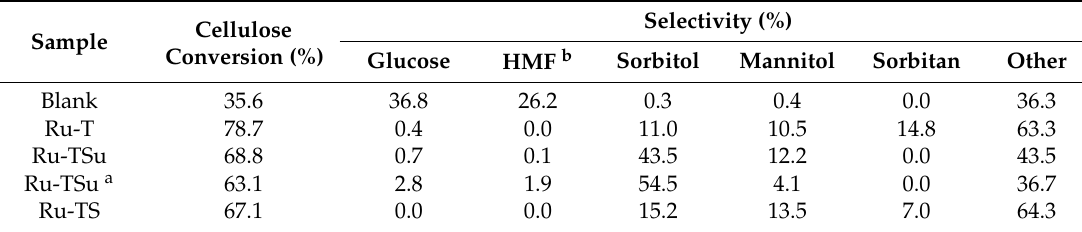
Table 6. Cellulose conversion and selectivity to several products.